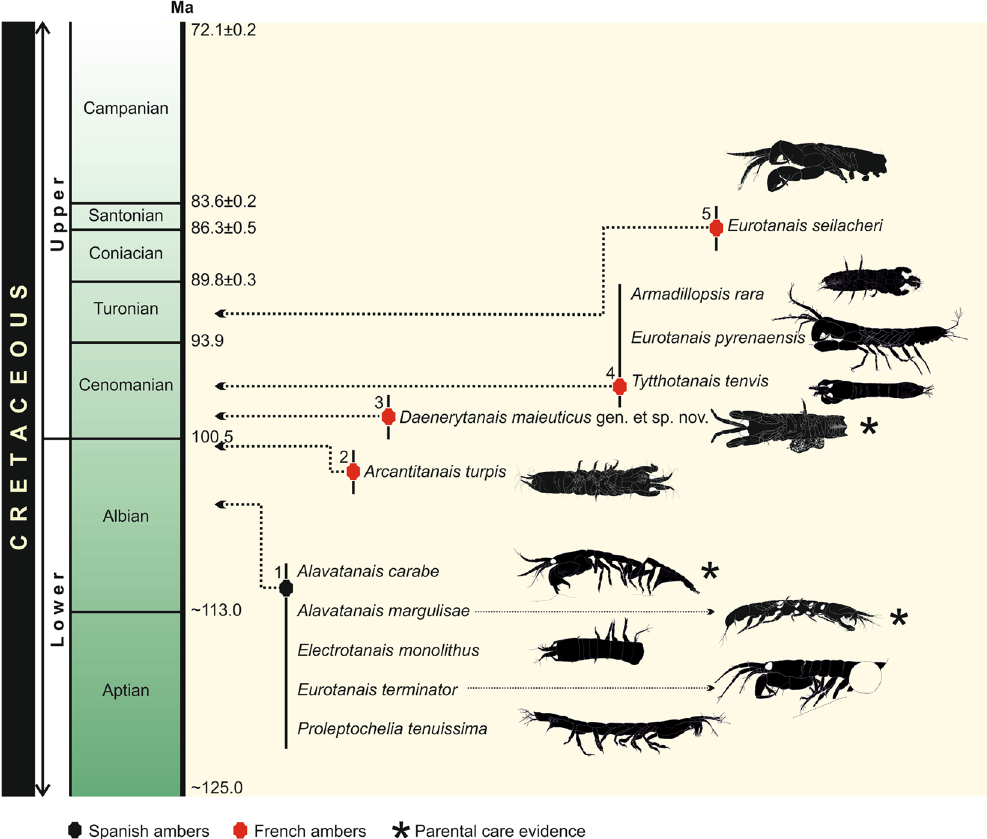
Figure 1. Timeline of fossil tanaidomorphans described from amber. 1 = Peñacerrada (Upper Albian), note that only one specimen of Alavatanais carabe was found in the El Soplao outcrop (Upper Albian), 2 = Archingeay/Les Nouillers (Upper Albian), 3 = Champniers/La Buzinie (Early Cenomanian), 4 = Fourtou (Middle Cenomanian), and 5 = La Garnache (Turonian). Numerical ages are from 70